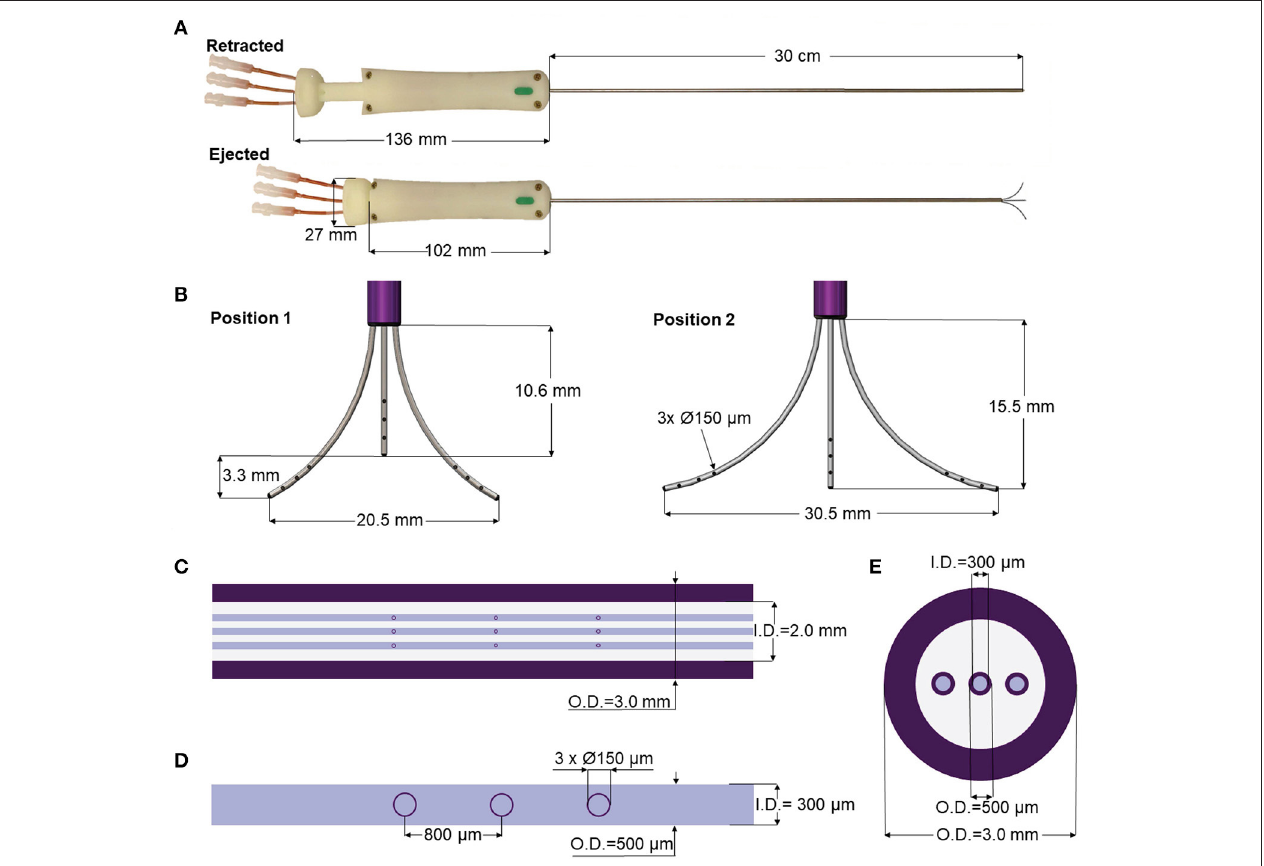
FIGURE 1 | MINT device design and dimensions. (A,B) Overview of the dimensions of the MINT catheter showing (A) (top) retracted and (bottom) ejected positions, and (B) ejected microcannula in (left) intermediately extended Position 1 and (right) fully extended Position 2. (C–E) Overview of the dimensions of the three actuated microcannulas including (C) details of the shaft dimensions, (D) the 3 infusion port dimensions (tapered end not shown), and (E) transverse section of the shaft with the embedded microcannulas in the retracted